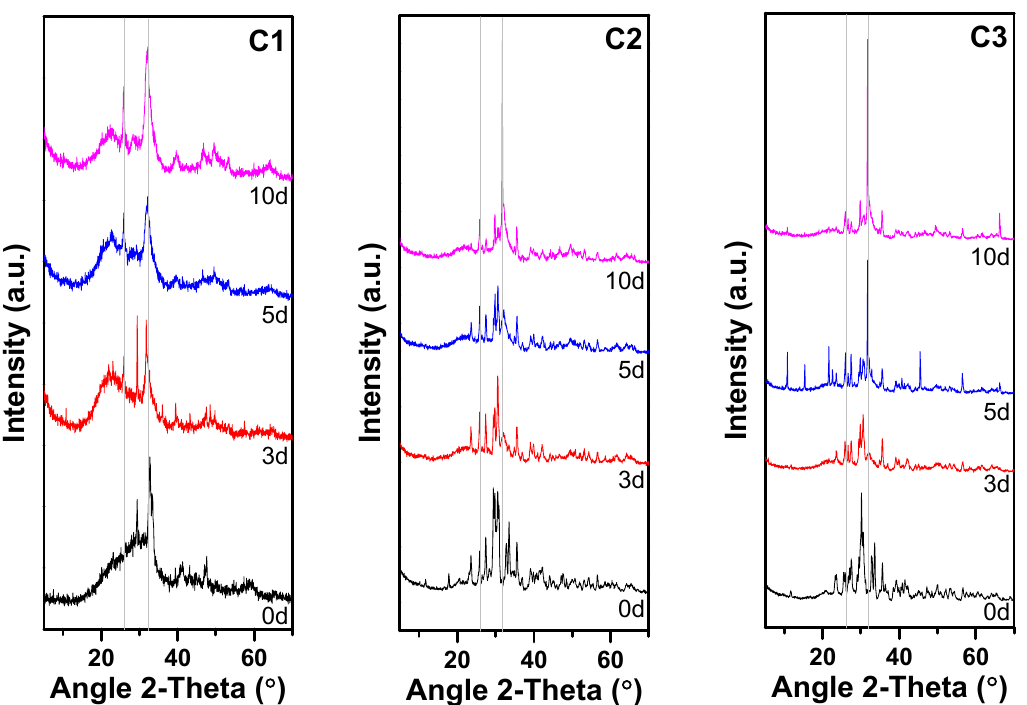
Figure 5. XRD patterns of all heated samples before and after 3, 5, and 10 days in SBF.